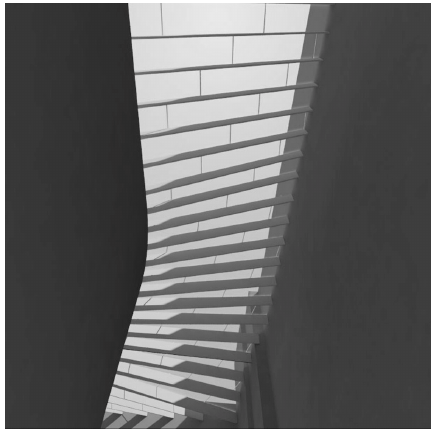
Figure 10: Internal rendering of glass roof Victoria & Albert